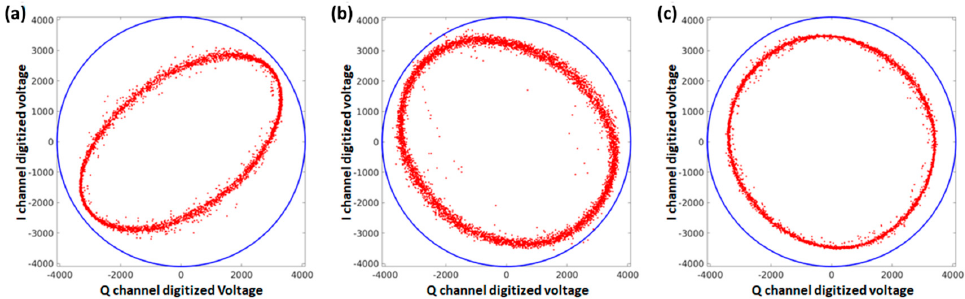
Figure 4. Amplitude ( left ) and phase ( right ) retrieved from the digitized signal. The amplitude is highest where the main energy of the pulse is sampled by the ADC, in this case at bin 16.